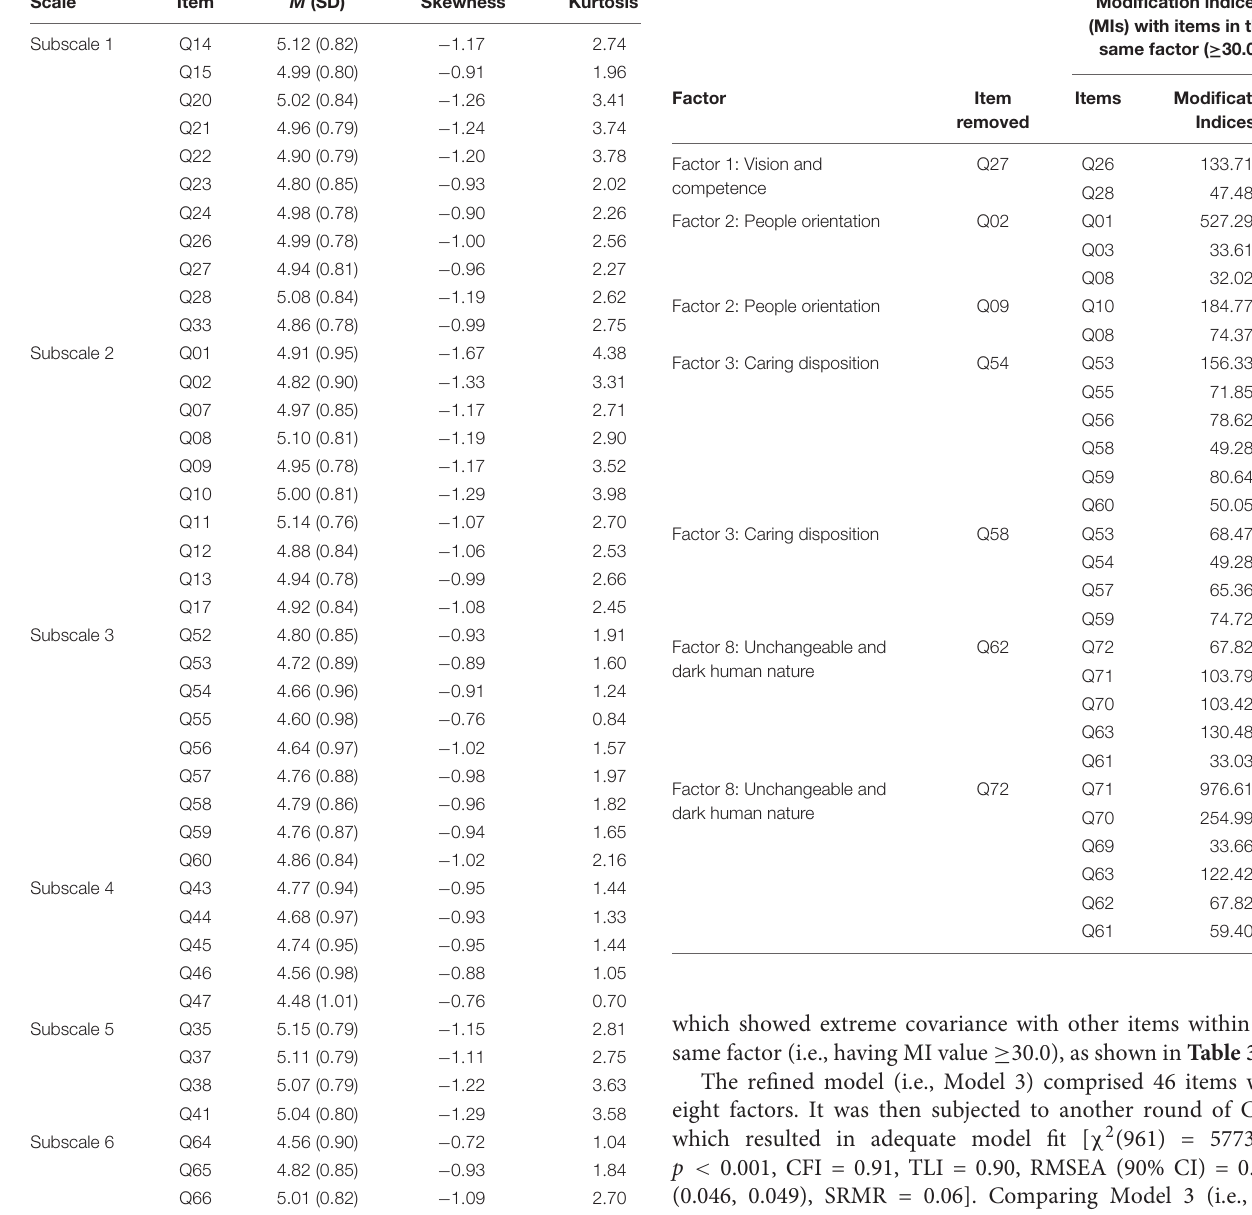
Modification indices (MIs) with items in the same factor ( ≥